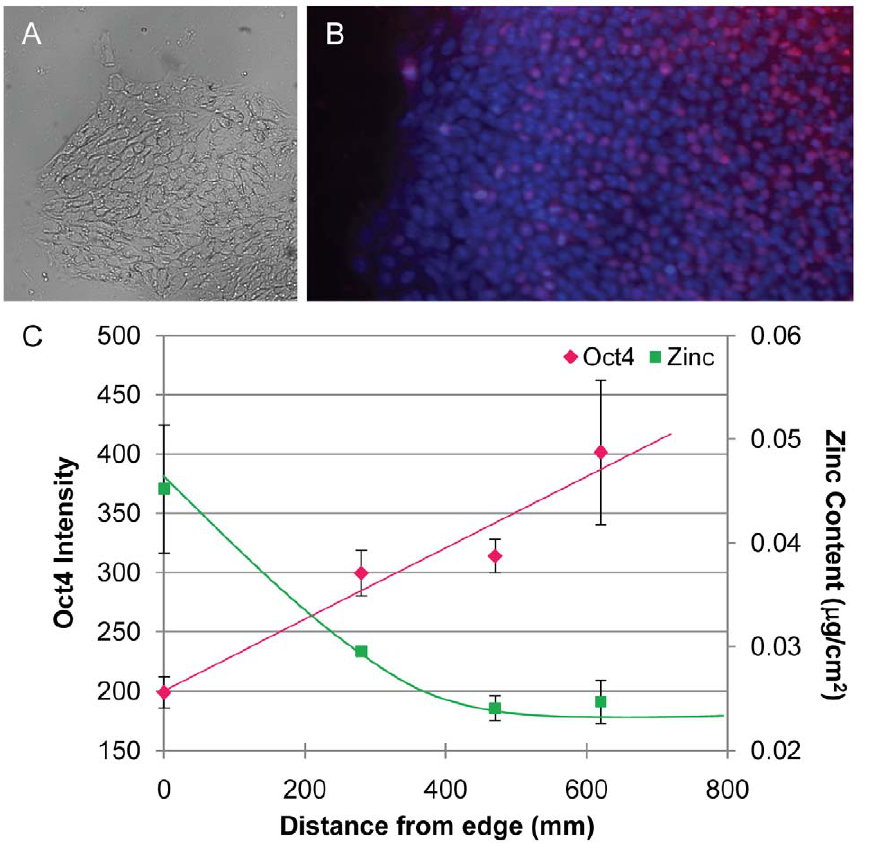
Figure 1. Spontaneous differentiation correlates with increased nuclear zinc content at hESC colony borders. A. DIC (10x) image of hESC colony showing a change in morphology at colony border. B. Oct4 labeling lost at colony border but maintained in center of colony indicates that pluripotency is maintained centrally. C. Graph depicting an inverse relationship between quantified Oct4 signal and zinc content from XFM analysis across the colony. Results are plotted as mean 6 SEM.